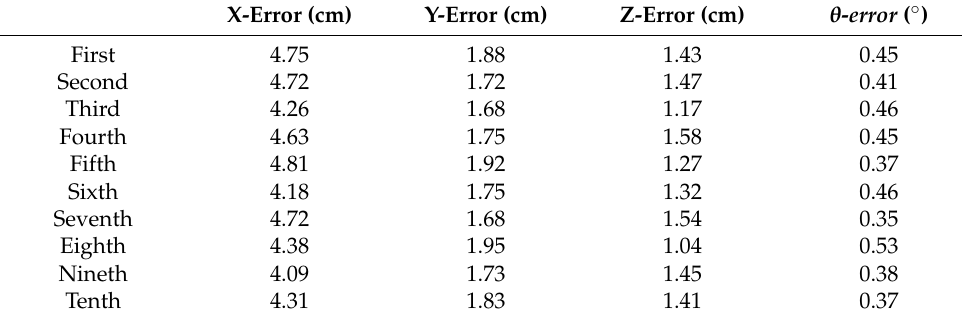
Table 2. 3D measurement